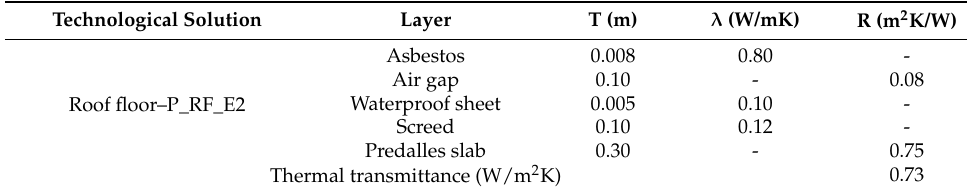
Table A6. Existing roof floor stratigraphy